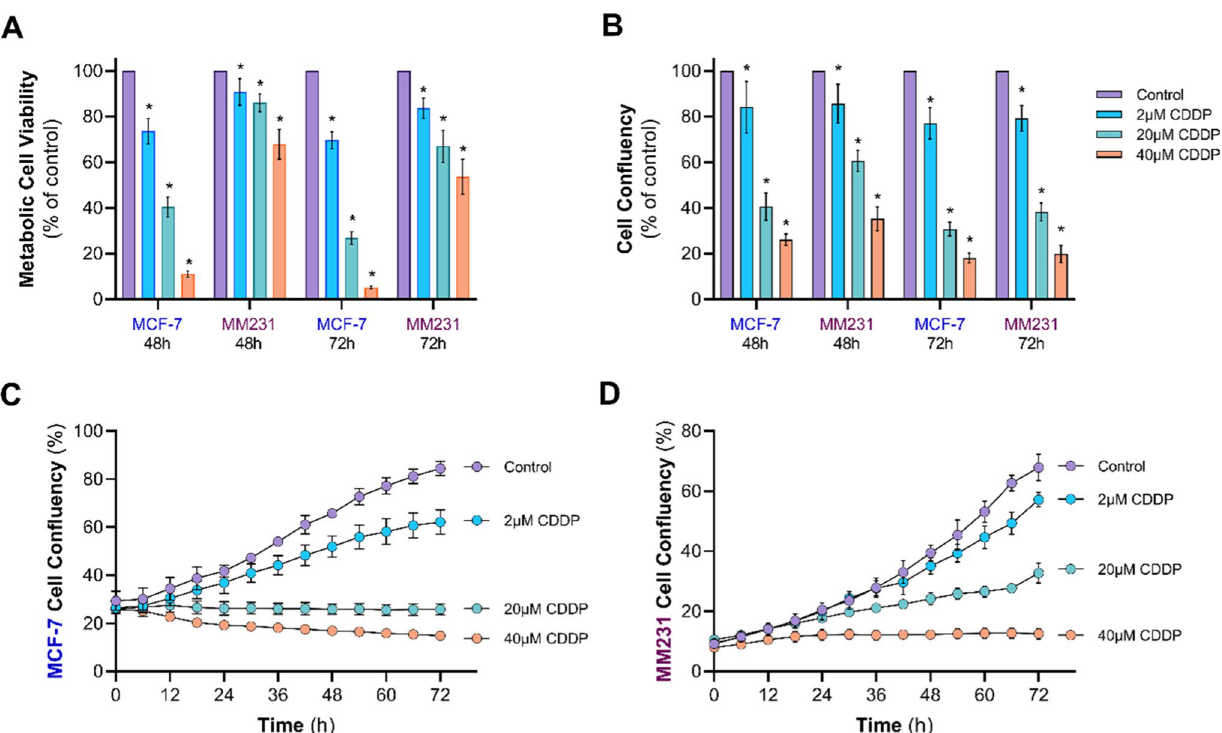
Fig. 1 Effects of CDDP on MCF-7 and MDA-MB-231 cells. MCF-7 and MDA-MB-231 (MM231) cells were incubated in DMEM containing 10% FBS either with vehicle control (0.1% PBS) or CDDP (2, 20 or 40 µM) for 48 and 72 h. A Metabolic cell viability determined by MTT assay and B cell confluency by IncuCyte live cell imaging system. A–B Cell viability and confluency were presented as fold change to time-matched vehicle control. Data presented in ( B ) were obtained from the timeline data for C MCF-7, and D MDA-MB-231 (MM231) cells. Data are mean ± SEM of three independent experiments performed in quadruplicate ( A ) or with six technical replicates ( B–D ). *p < 0.05 vs. Control within each experiment by one-way ANOVA followed by Dunnett’s post hoc test ( A & B )